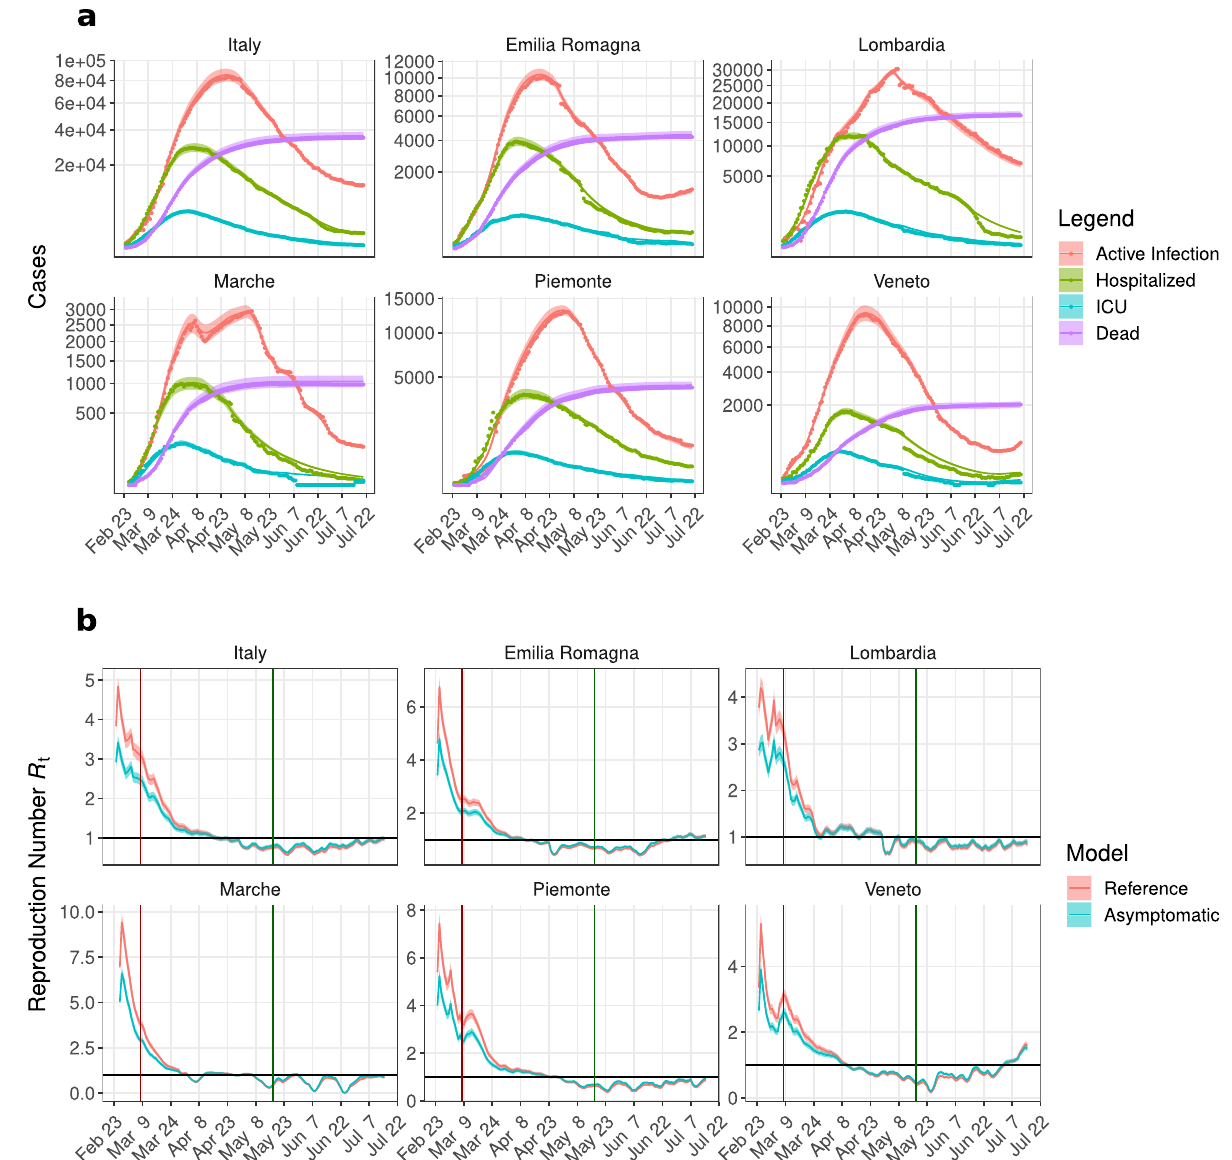
Fig. 4 Reference Model and time-dependent reproduction number R t in different regions of Italy. a Active infections, hospitalized, Intensive Care Units (ICU) and death data (nationwide and region-wise) were fi tted in a sliding one week time window. Parameter ranges listed in Table 1 were used and the behavioral parameters ( R 1 , R 10 , ρ , ϑ , δ ) were estimated in each time window (see Methods); dots: data; continuous lines and shaded area: respectively, mean and standard deviation of all dynamics generated by using 100 perturbed parameter sets (see Methods). b Dynamics of the time-dependent reproduction-number, R t , resulting from the fi t with the Reference (red) and the Asymptomatic Model (blue). Statistics of R t were obtained by fi tting the data with 100 perturbed parameter sets; continuous lines and shaded area are, respectively, mean and standard deviation. Vertical lines correspond to the Lockdown implementation (dark red) and release (dark green). Black horizontal line represents R t ¼